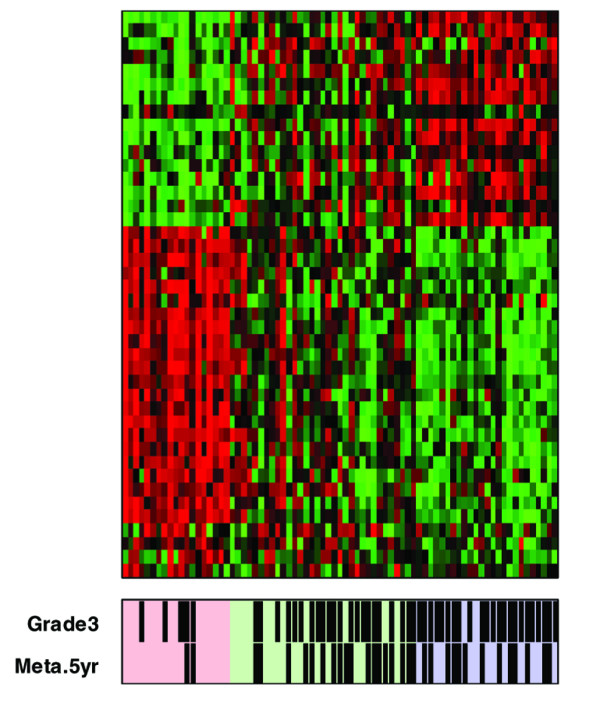
Supervised clustering of the van't Veer cohort (n = 78) using 42 genes of the 64-gene set. Meta.5 yr, black if the patient had distant metastasis within 5 years.